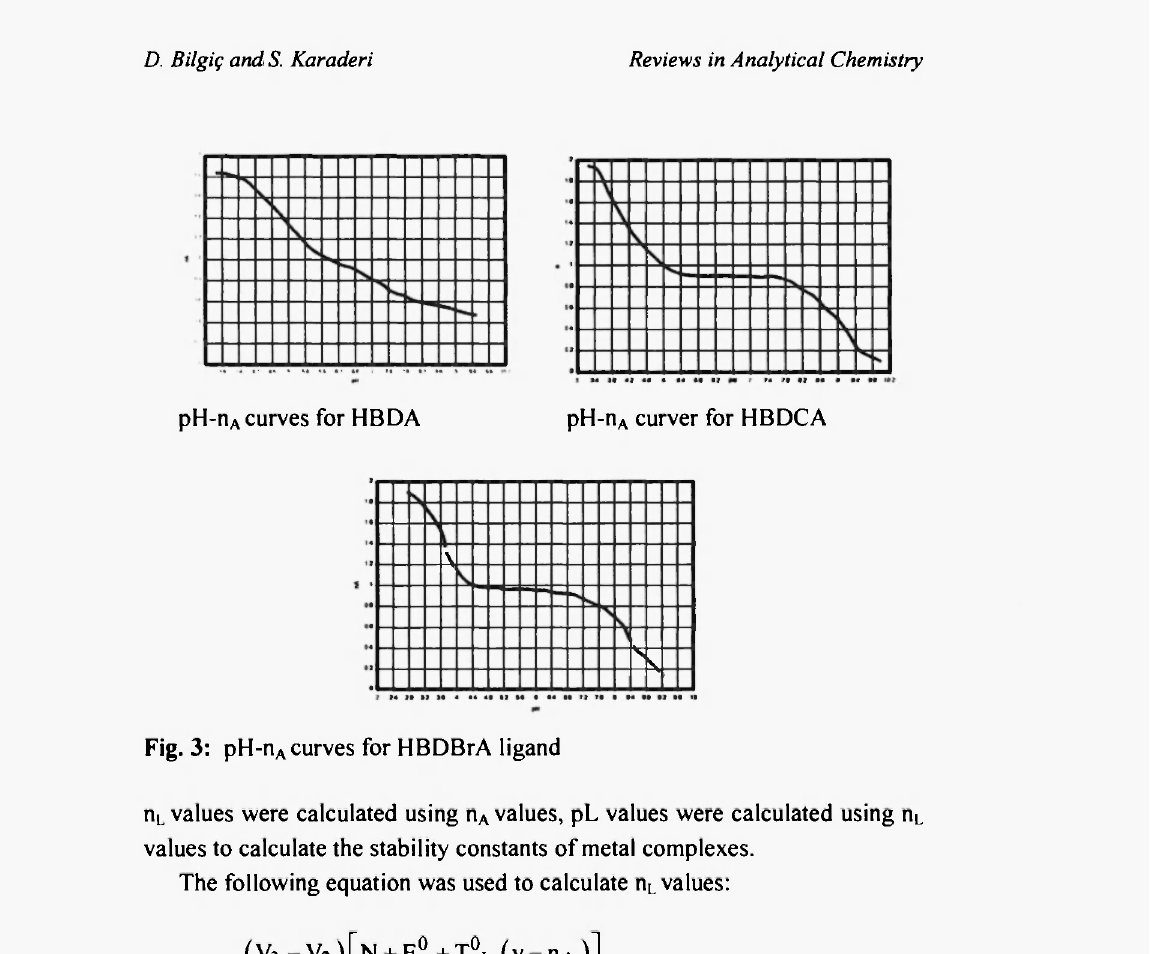
Fig. 3: pH-n A curves for HBDBrA